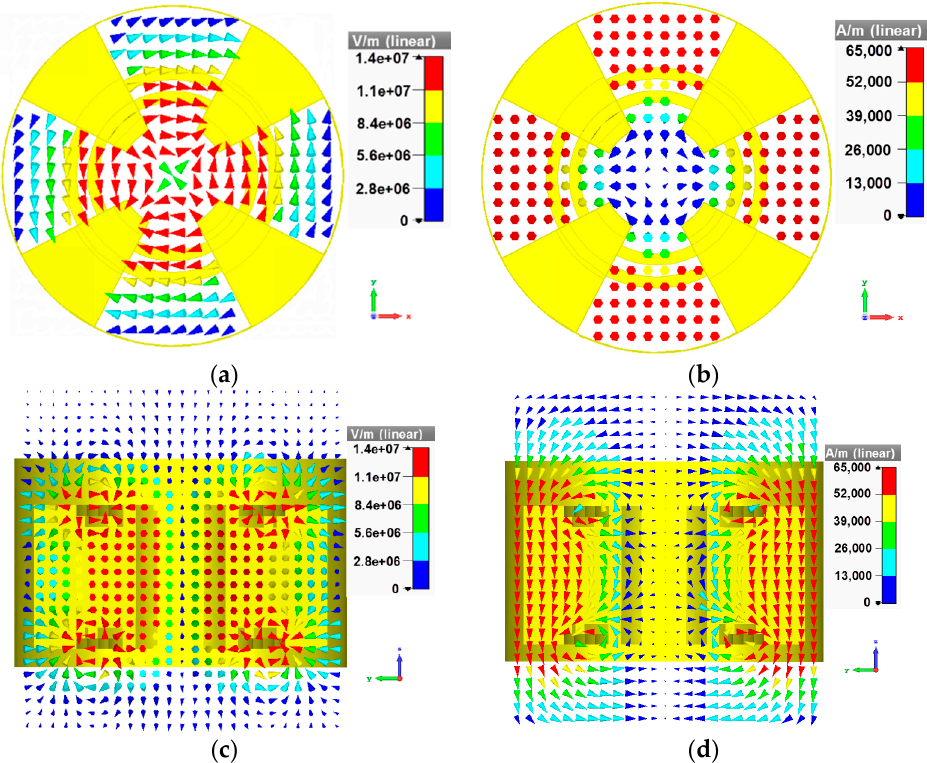
Figure 2. Field distributions of the π mode: ( a ) Electric field distribution from the cross-sectional view, ( b ) magnetic field distribution from the cross-sectional view, ( c ) electric field distribution from the longitudinal section view, and ( d ) magnetic field distribution from the longitudinal section view.